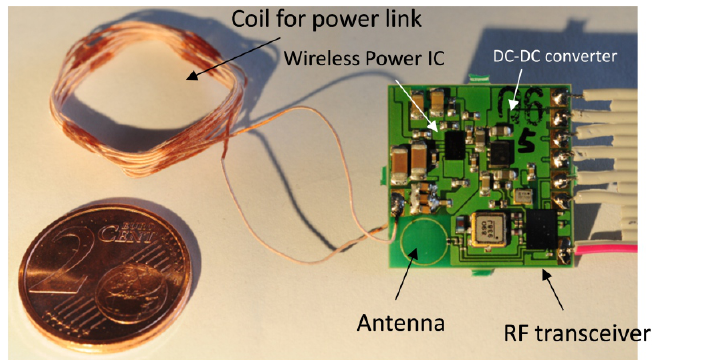
Figure 2. Realization of the wireless module on a 0.15 mm FR4 board with its hand wound coil for the inductive power link.